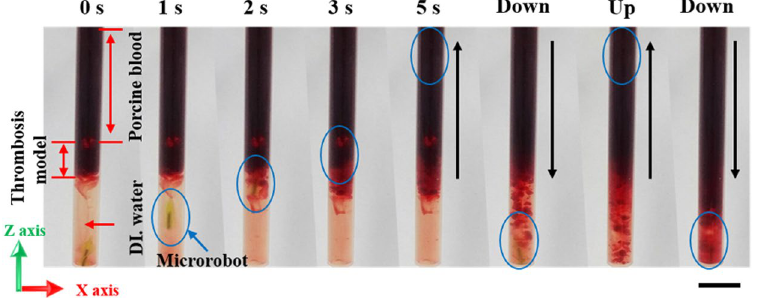
Figure 4. Drilling performance of MDA. Drilling performance of the MDA with an artificial thrombosis model in a single cylindrical tube on the vertical plane. Scale bar represents 10